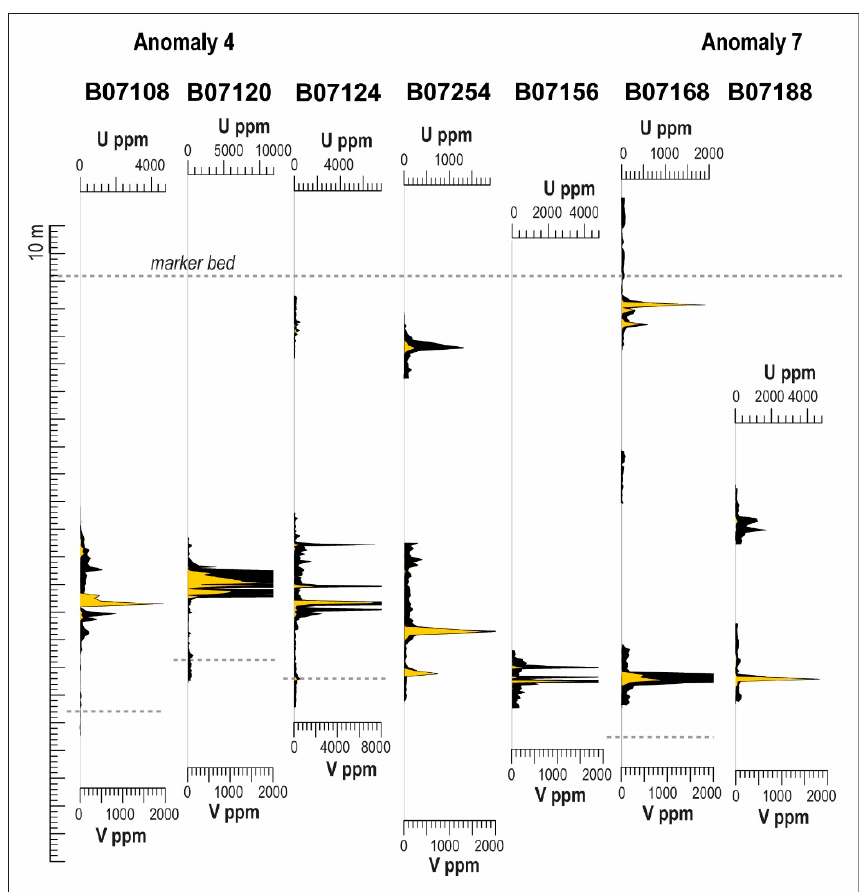
Figure 5. Distribution of mineralization for a transect from the A4 to A7 sub-deposits corrected for stratigraphic level using the upper marker bed (grey dashed line). Uranium abundance in yellow, vanadium abundance in black.